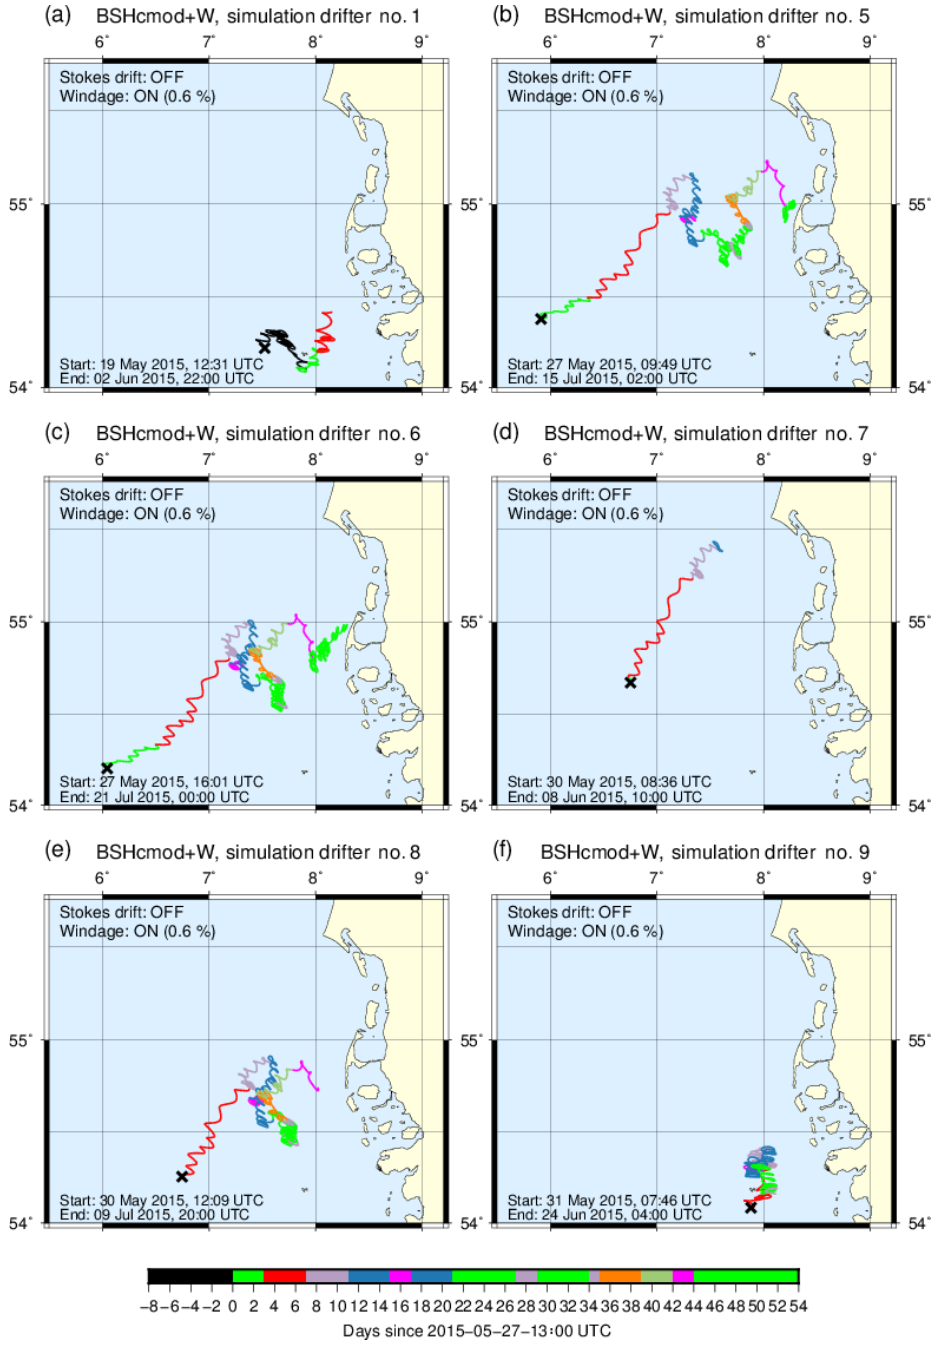
Figure A2. Simulations based on BSHcmod top-layer currents plus 0.6% of 10m wind velocity (BSHcmod + W). Black crosses indicate locations where simulations were